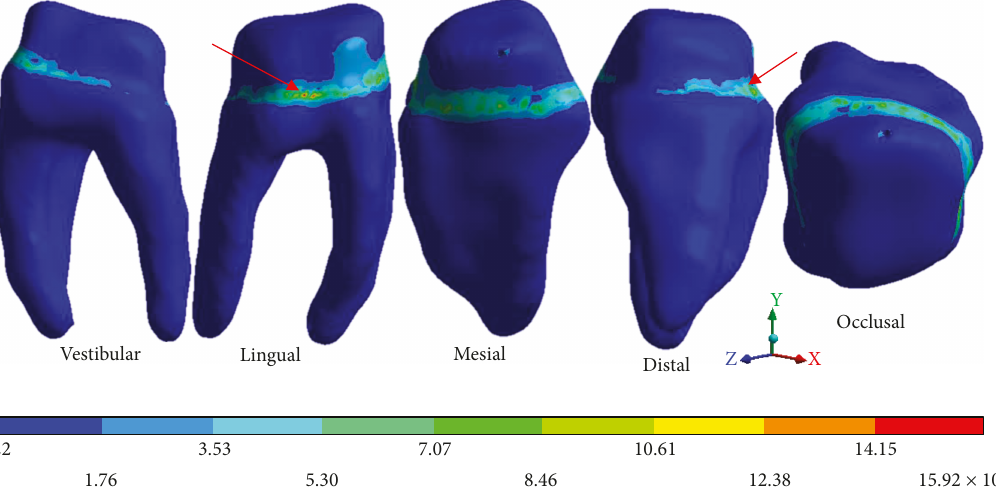
Figure 16: 3rd degree caries : von Mises stresses in dentin.